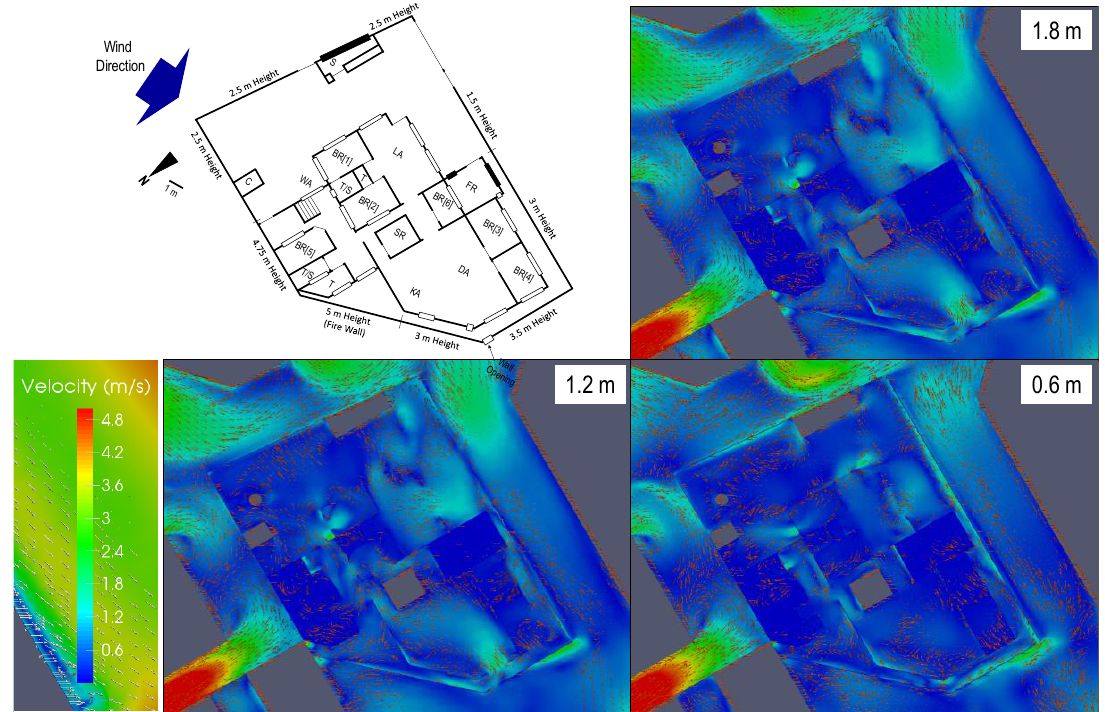
Figure 12. Case 7 — High lot perimeter wall and firewall with left lot perimeter wall opened (all windows opened and all doors closed, wind velocity around and inside the detached family house for three vertical heights (1.8 m, 1.2 m and 0.6 m above the floor).